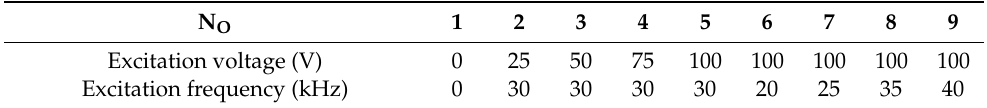
Table 1. Ultrasonic excitation